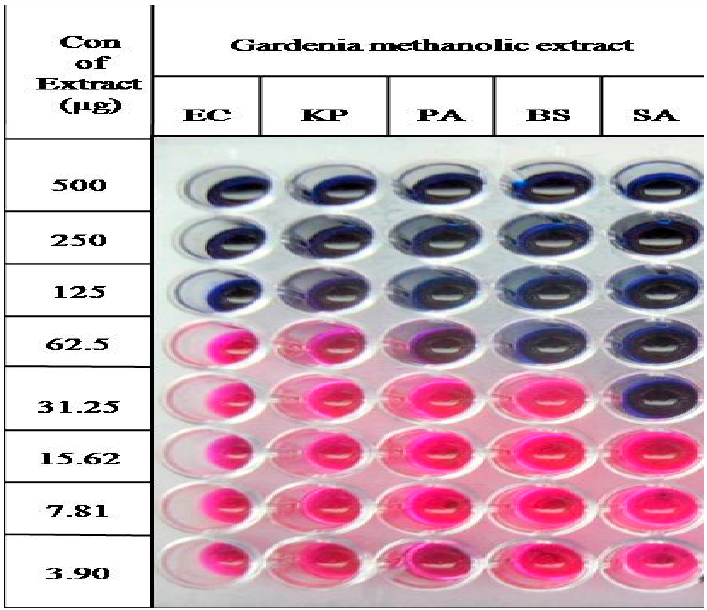
Figure 5. Minimum inhibitory concentrations of methanolic fruit extract of G. latifolia against Gram negative and positive bacteria.